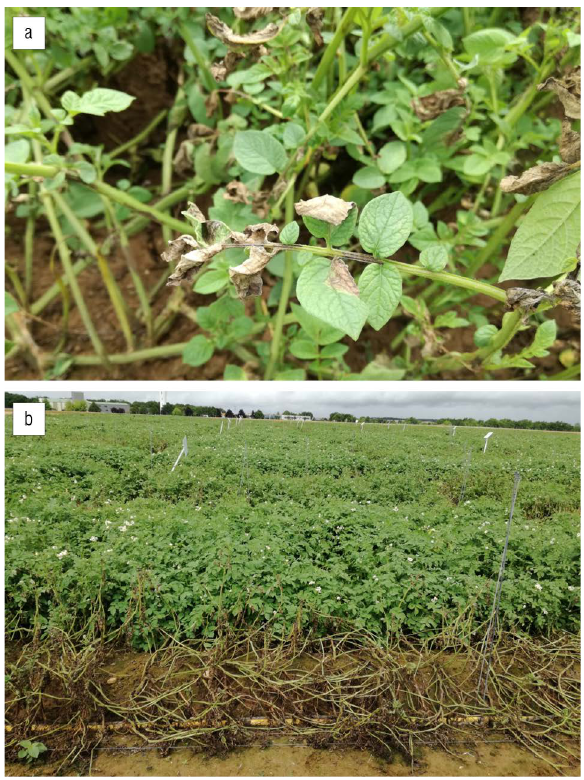
Figure 1: (a) Initial late blight symptoms on potato foliage. (b) Destruction of a susceptible potato cultivar (foreground) in a field.